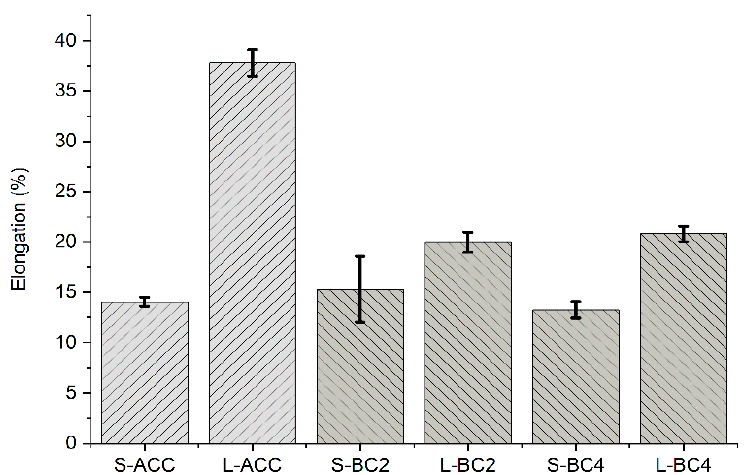
Figure 3. Elongation at break (%) for ACC and biocomposites. Measurements were performed in two directions, where S stands for the Spinnova–Lyocell (weft) direction and L stands for the Lyocell (warp) direction. Lighter shade is used for ACC, darker for BC.